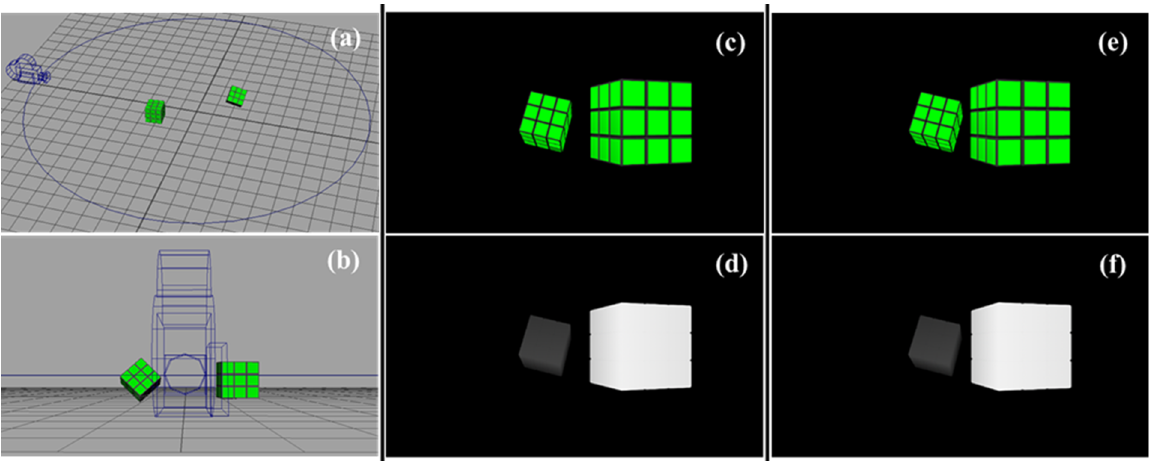
Figure 3. Geometry for extracting RGB and depth map information and examples of RGB and depth map images: geometry in a perspective view ( a ) and in a camera-lens view ( b ). ( c , d ) are a set for the left eye, and ( e , f ) are for the right eye. Each image of FHD resolution is extracted at a given view from a virtual camera set to capture the RGB color and depth map images.